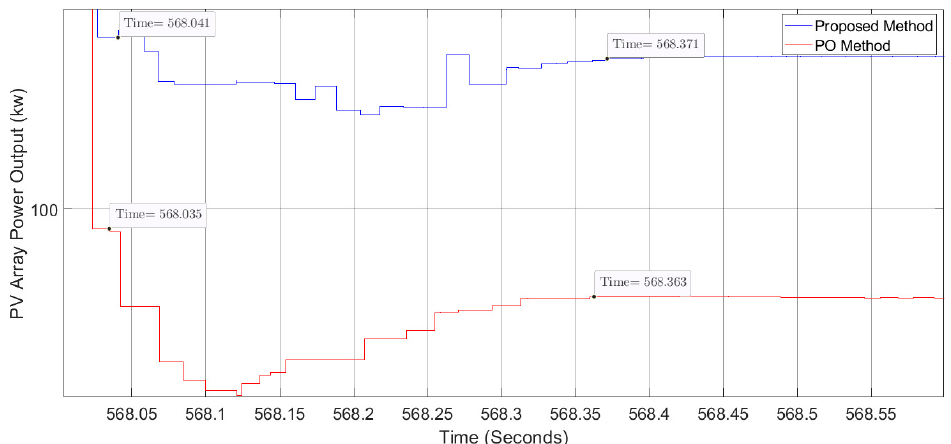
Figure 12. Sample of the output power of the proposed method and the PO method for a period (568 – 568.55) of time on a cloudy day.